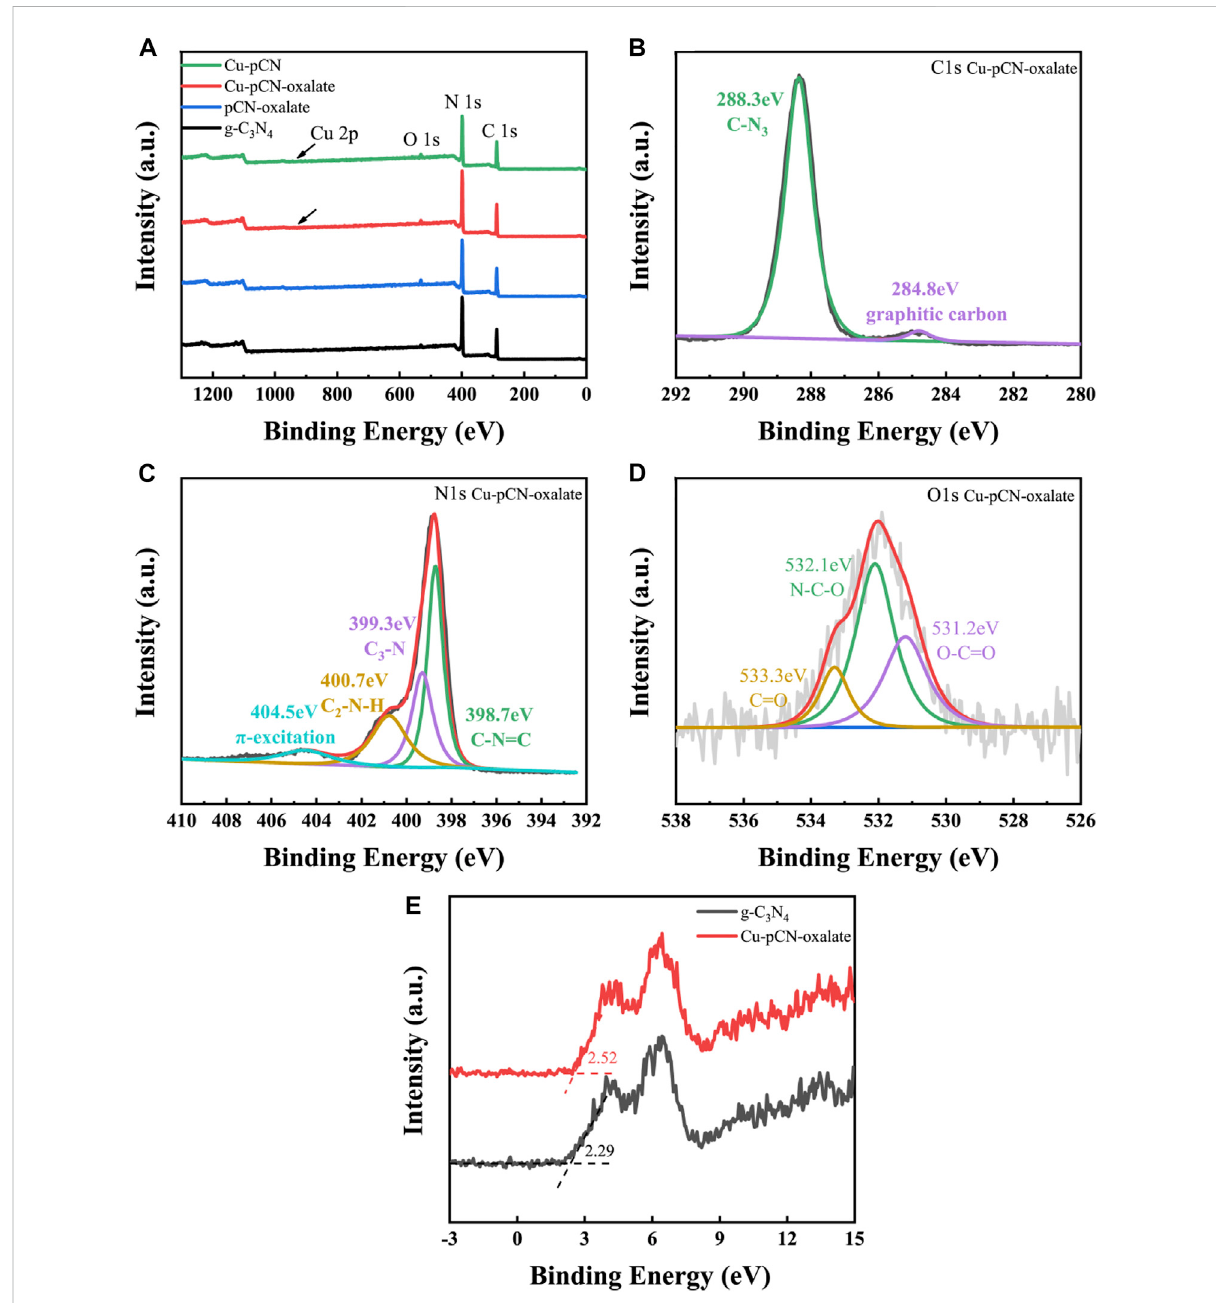
FIGURE 6 (A) XPSsurveyspectraofrawg-C 3 N 4 andCu-pCN-oxalatesamplesand (B – D)